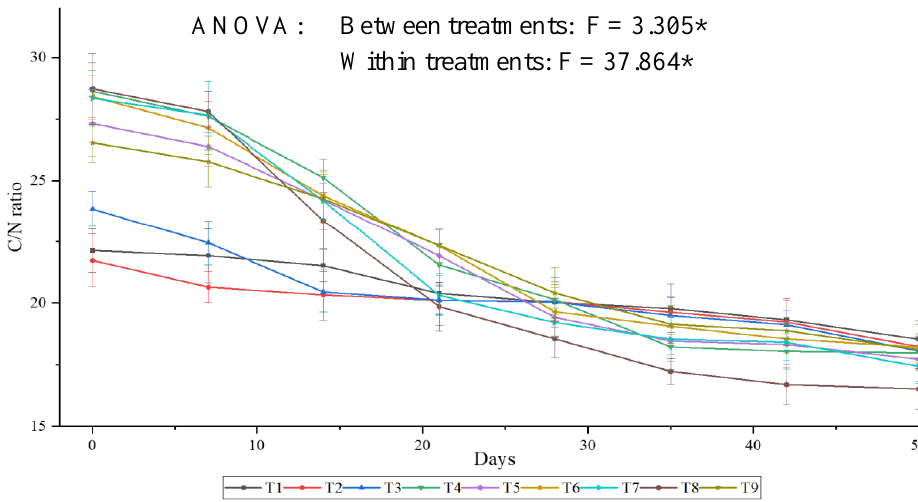
Figure 6. Profile of C/N ratio variations among different composting treatment groups. ‘*’ indicates a significant difference at p < 0.05 by ANOVA.